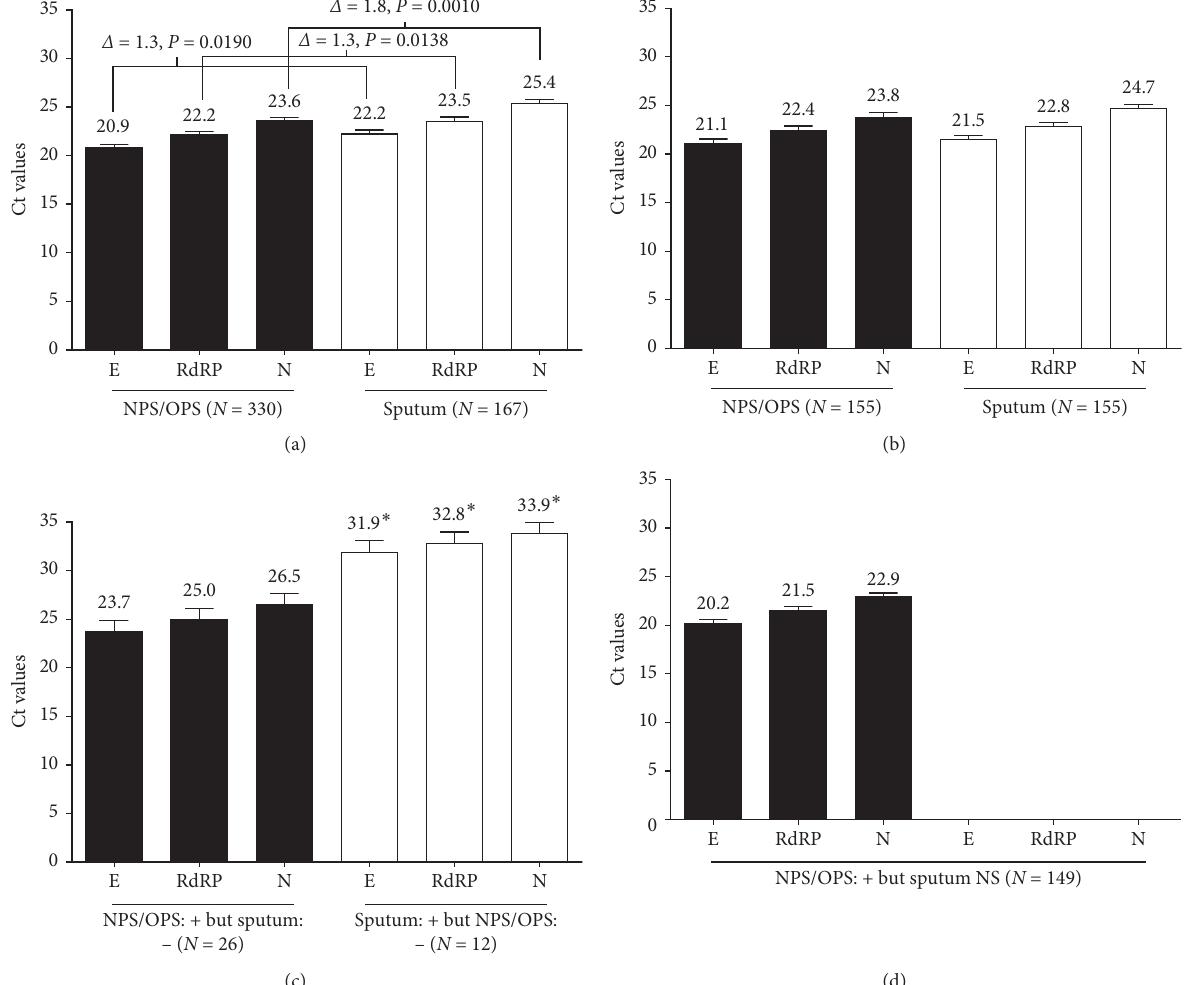
Figure 2: Ct values of the E, RdRP, and N genes in the Allplex 2019-nCoV assay for SARS-CoV-2 performed on nucleic acids extracted from the NPS/OPS and sputum specimens collected from the study group ( N � 342). (a) Ct values of the E, RdRP, and N genes detected in NPS/ OPS ( N � 330) and sputum ( N � 167) specimens among all study subjects ( N � 342). (b) Ct values among the study subjects ( N � 155) who were classified as positive for SARS-CoV-2 in both NPS/OPS and sputum samples. (c) Ct values among the study subjects ( N � 26) who were classified as positive for SARS-CoV-2 in NPS/OPS but negative in sputum (NPS/OPS + but sputum − ) and the subjects ( N � 12) classified as negative for SARS-CoV-2 in NPS/OPS but positive in sputum (NPS/OPS – but sputum +). (d) Ct values among the study subjects ( N � 149) who were classified as positive for SARS-CoV-2 in NPS/OPS even though their sputum specimens were not submitted. Ct: cycle threshold; SARS-CoV-2: severe acute respiratory syndrome coronavirus 2; NPS: nasopharyngeal swab; OPS: oropharyngeal swab; E: envelope protein gene; RdRP: RNA-dependent RNA polymerase gene; N: nucleocapsid protein gene. ∗ Significant difference; differences in Ct values of the E, RdRP, and N genes between those who were SARS-CoV-2 positive in tests on the NPS/OPS specimens but negative in tests on sputum ( N � 26) and those who were negative in tests on their NPS/OPS specimens but positive in tests on their sputum ( N � 12) were 8.2, 7.8, and 7.4, respectively, which were significantly different ( P ≤ 0 .